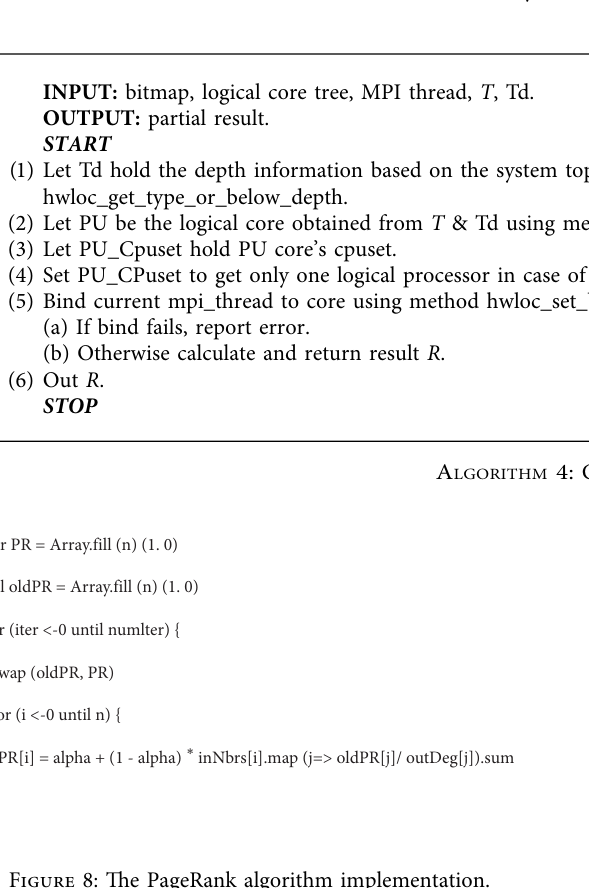
Figure 8: The PageRank algorithm